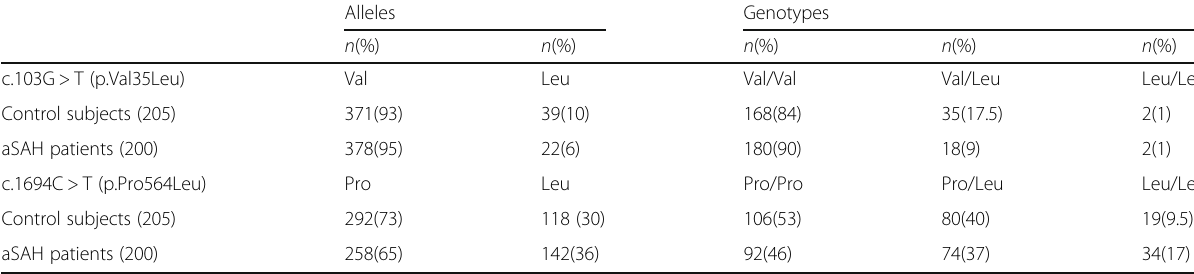
Table 1 Genotypes and allele frequency of F13A polymorphisms in aSAH Cases and Controls